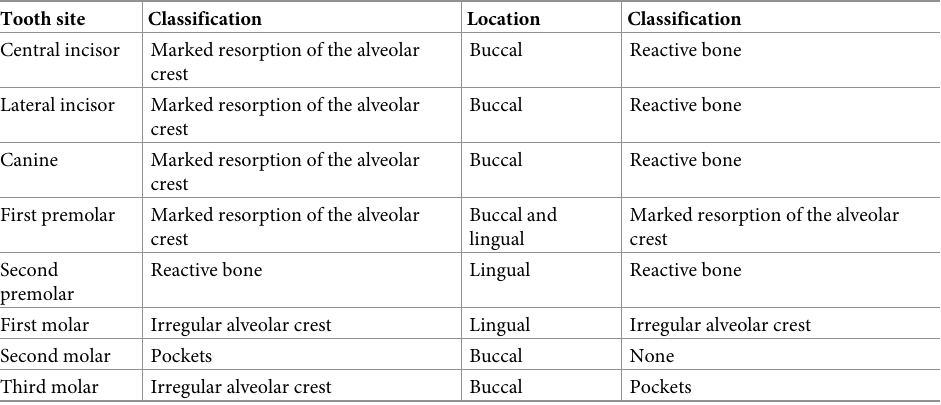
Table 5. Periodontal disease (after [44]) across the Maros-LBB-1a right